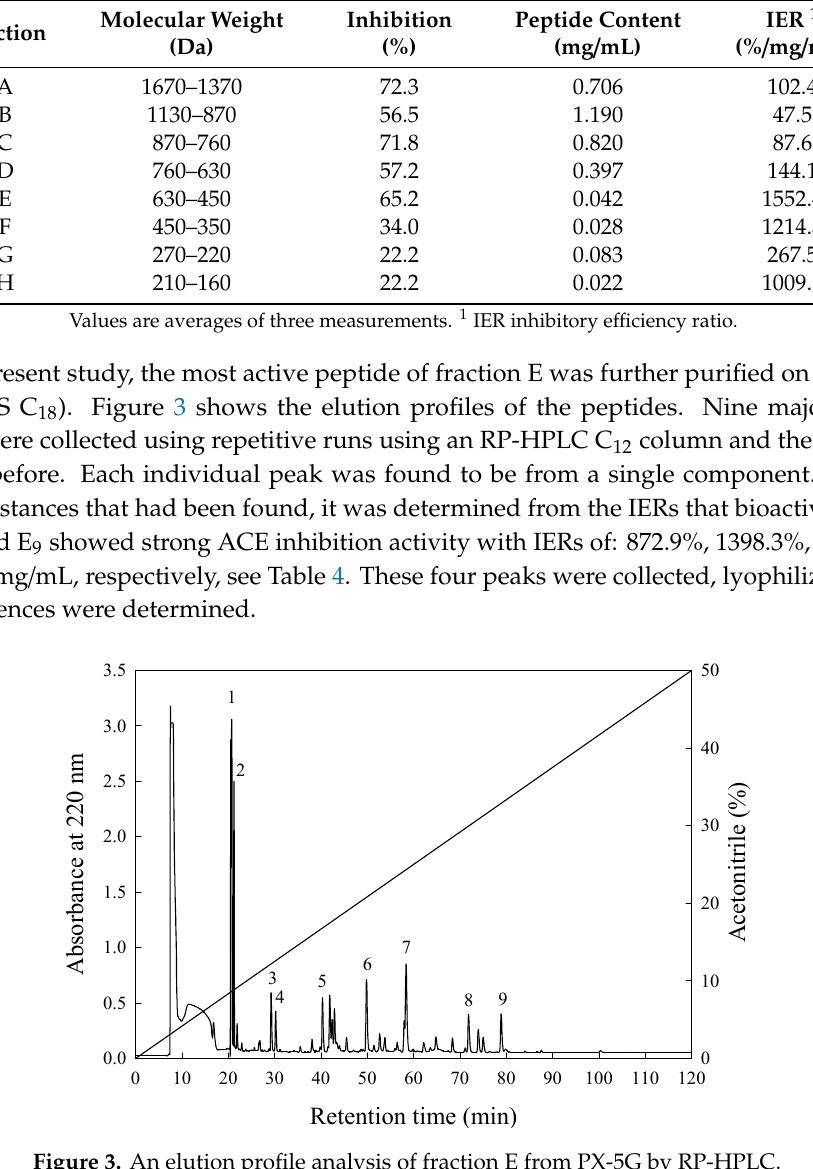
Table 3. ACE IC 50 values of fractions obtained by size exclusion chromatography from PX-5 after gastrointestinal digestion.